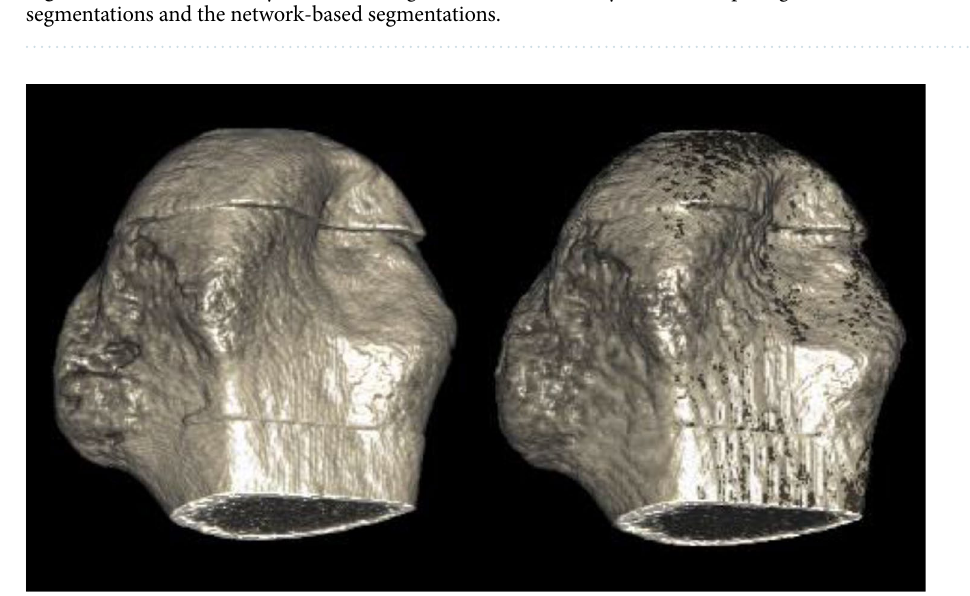
Figure 4. Volume rendering of the expert annotation (left) and the network prediction (right). The binary masks were multiplied with the HR-pQCT volume to yield the respective bone volumes. Note that the rendering of the prediction appears slightly degraded due to the up-sampling as part of the post-processing pipeline. The bones were rendered using MeVisLab version 3.1.0 (https:// www. mevis lab.